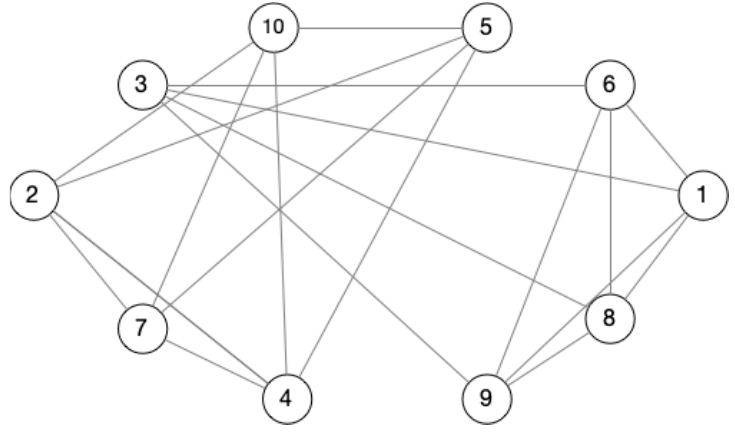
Figure 11. Subgraph with positive edges.